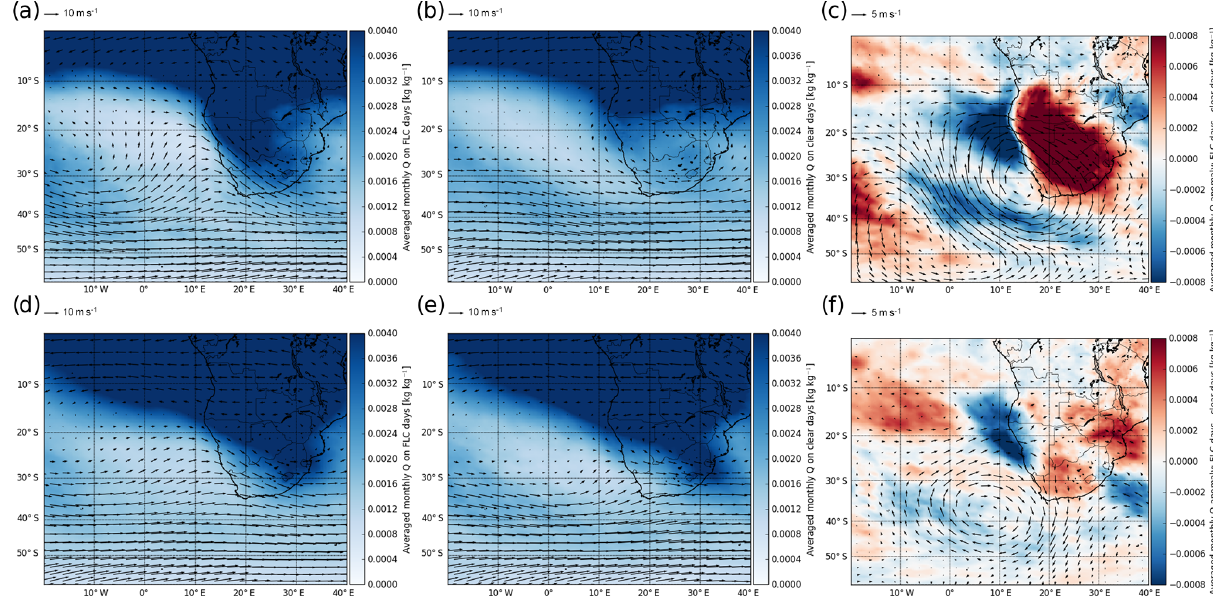
Figure A1. Seasonal averages of Q and winds at 700hPa on (a, d) FLC days, (b, e) clear days, and (c, f) their difference during (a–c) AMJ and (d–f)